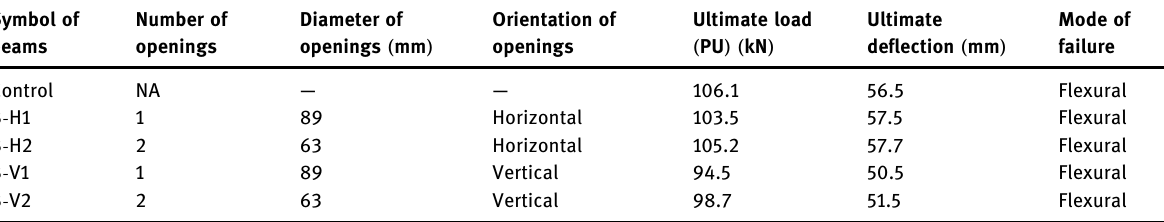
Table 3: Results of ultimate load and ultimate de fl ection for the proposed beams Symbol of